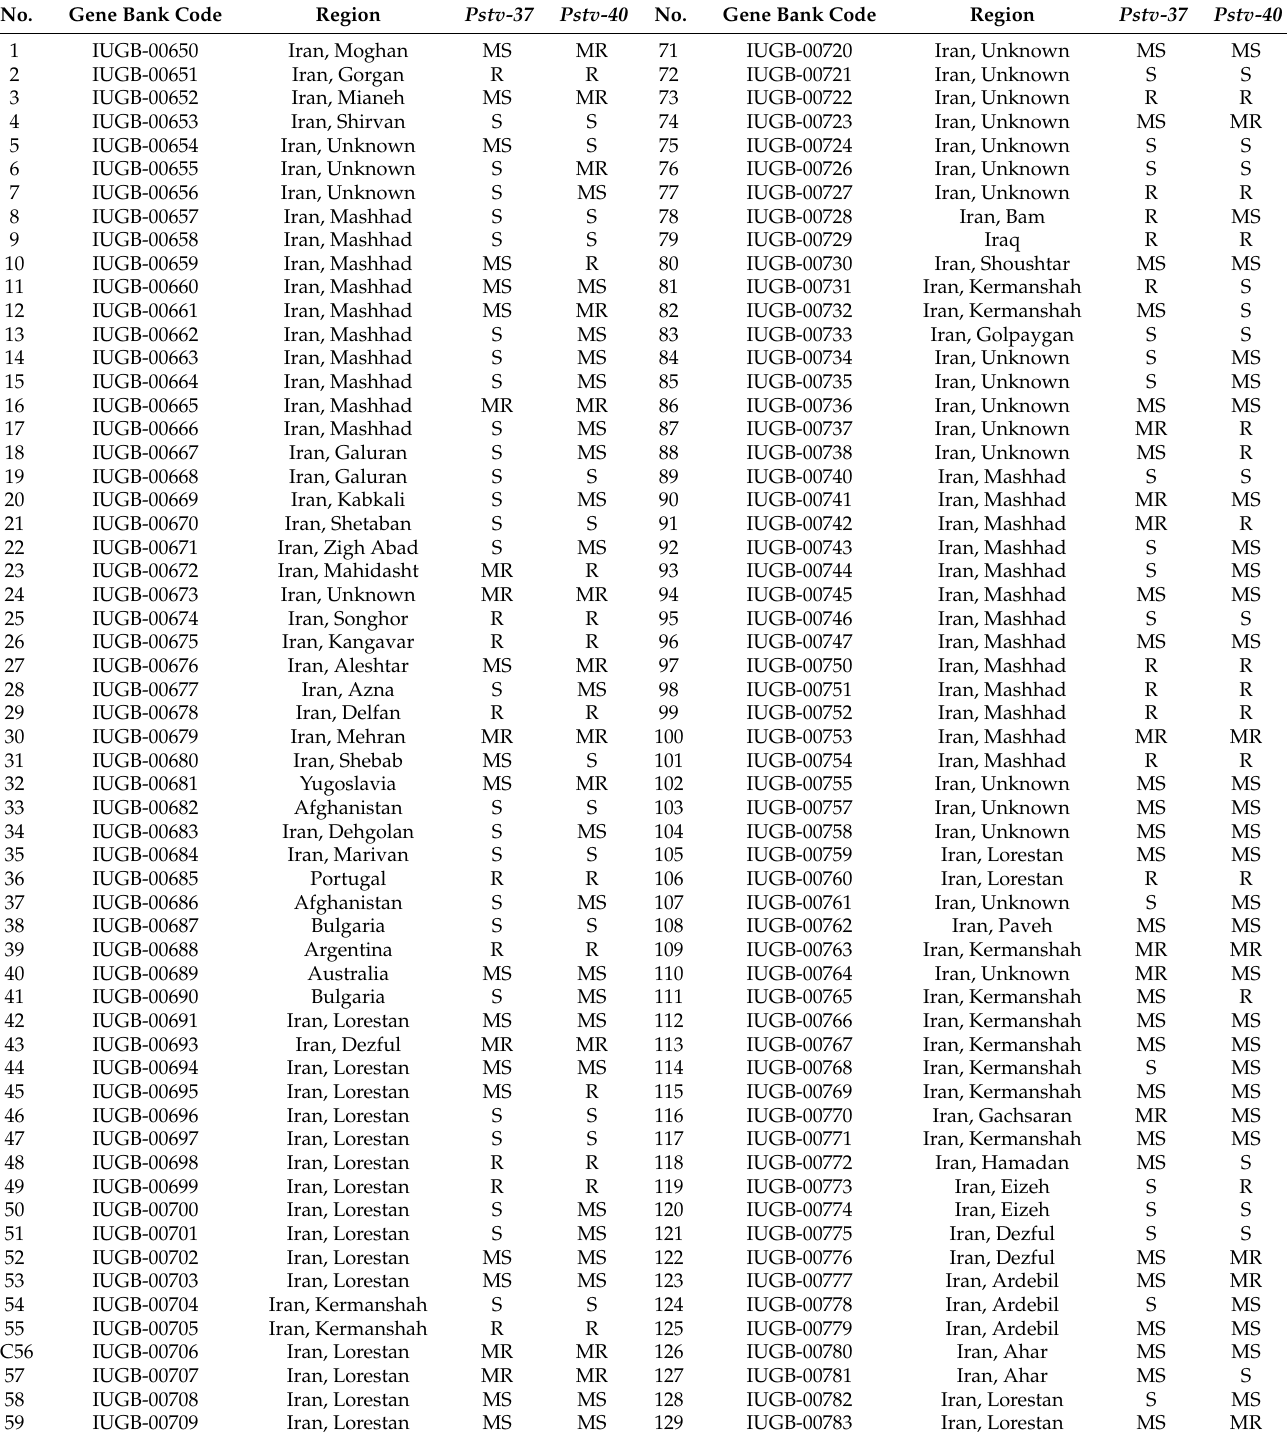
Table 1. Passport and disease reaction data of durum wheat landraces used in a genome-wide association study of stripe rust